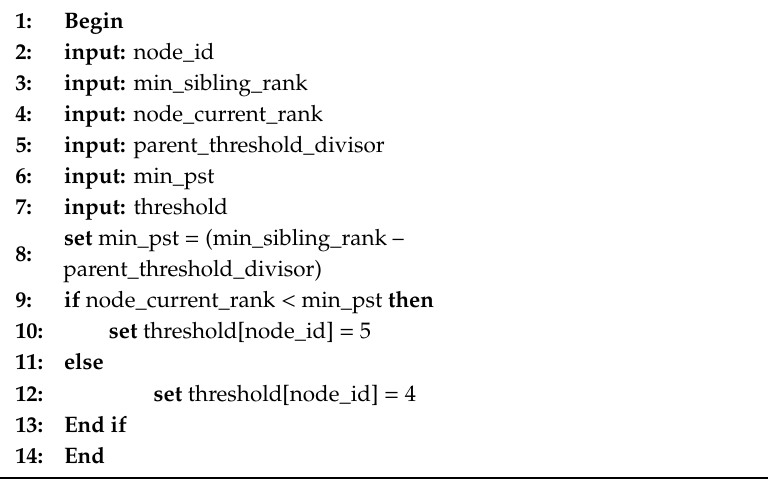
Algorithm A1. Evaluation of Node Current’s Rank and Node Sibling’s Rank